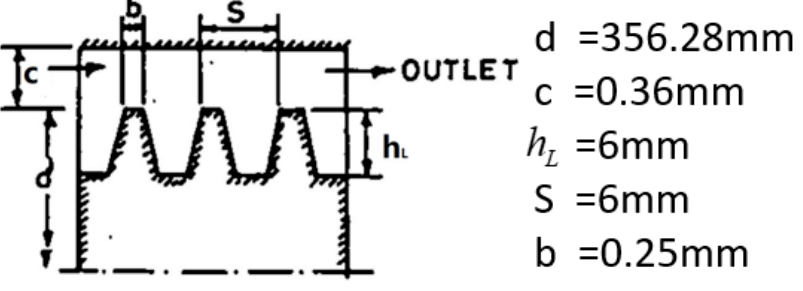
Figure 2. Geometry of labyrinth.